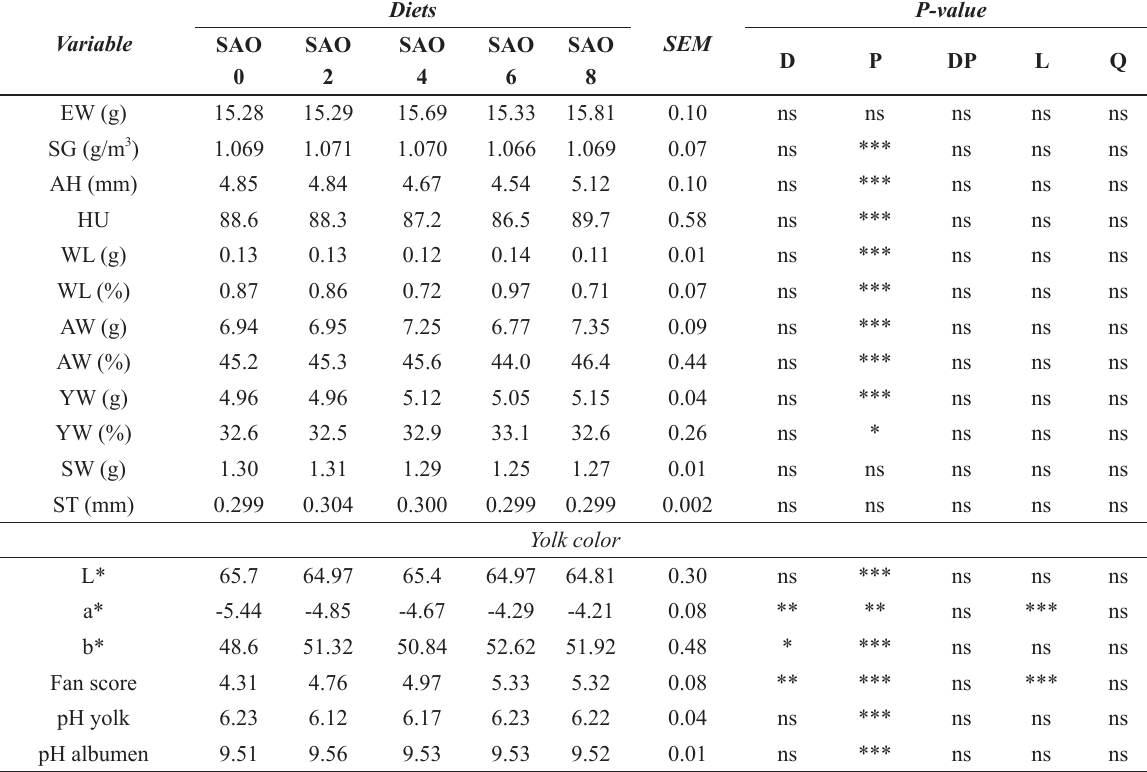
Effect of storage time on quality of quail eggs after eight weeks. Quails were fed with increasing levels of soybean acid oil as replacer of soybean oil in the